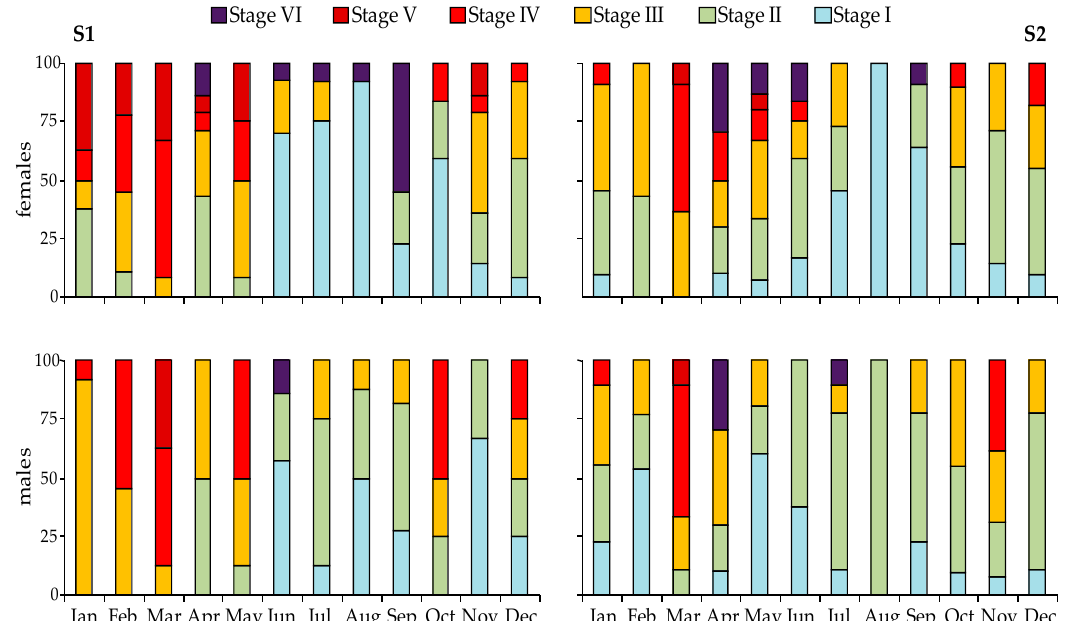
Figure 8. Temporal trend of the relative frequency of each gonadal developmental stage of female and male Sphaerechinus granularis individuals at the two sampling stations (S1, S2) in Pagasitikos Gulf (I = recovery, II = growing, III= premature, IV = mature, V = pre-spent, VI = spent).